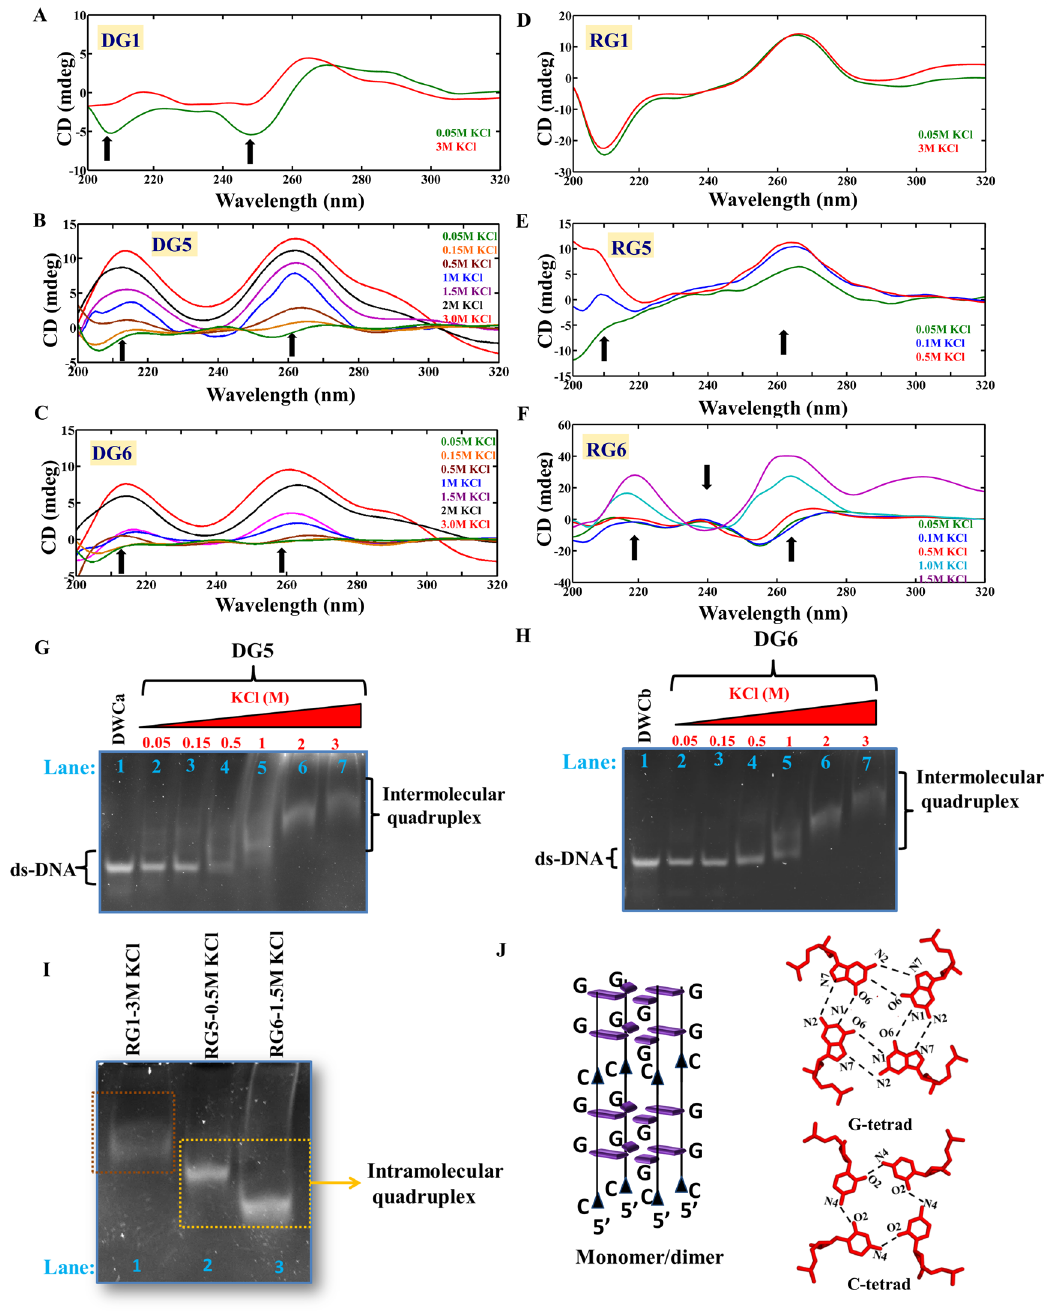
Figure 1. Circular dichroism spectra and EMSA corresponding to DNA and RNA CGG sequences. ( A – F ) CD spectra and ( G – I ) PAGE showing the preference for the following conformations by DG1, DG5, DG6, RG1, RG5, and RG6: ( A ) B-form duplex (0.05 M KCl)/intermediate conformation (3 M KCl) (DG1), ( B , C , G , H ) intermolecular quadruplex (DG5 and DG6), ( D ) A-form duplex (RG1) and ( E , F , I ) intramolecular quadruplex (RG5 and RG6). ( J ) Schematic diagram illustrating the arrangement of G- and C-quadrats (taken from PDB ID: 1EVO) in a parallel RNA and DNA CGG quadruplex. This figure was generated by using pymol 1.3 (www. pymol. com). The arrows indicate the increase or decrease in the ellipticity concomitant with the change in the secondary structure (see the text for more details). The figures ( A – F ) were plotted by using MATLAB 7.11.0 software (www. mathw orks. com). The EMSA ( G – I ) samples were analysed by 14% native PAGE and stained with ethidium bromide (EtBr). The unprocessed gel images ( G – I ) are incorporated in Supplementary Fig.